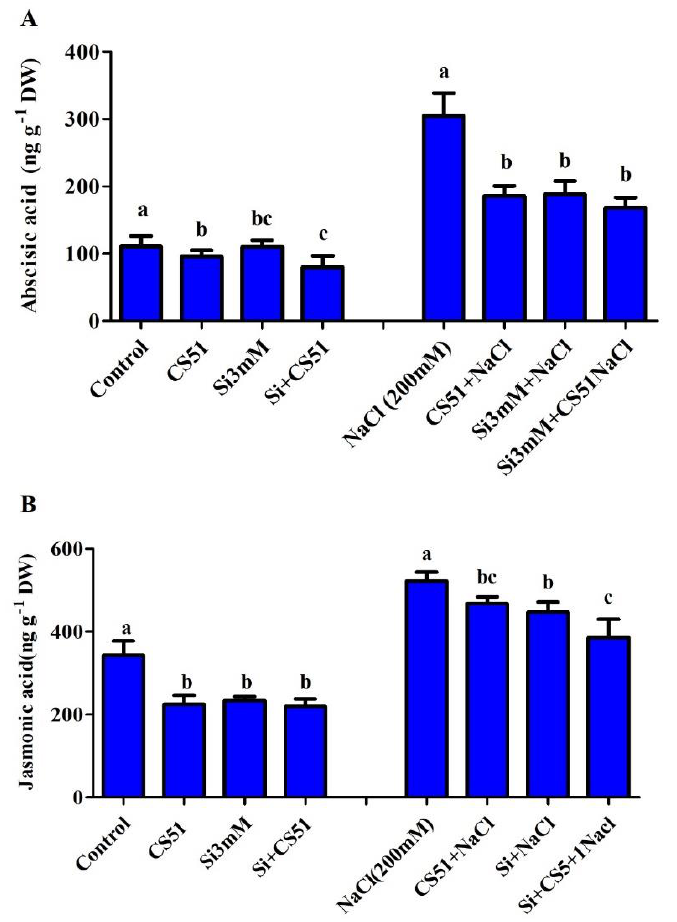
Figure 4. Effect of strain isolate CS51 and Si on ( A ) abscisic acid (ABA) contents and ( B ) jasmonic acid (JA) contents of maize plants grown under elevated NaCl 200 mM. Each value represents the mean ± SD of three replicates. Different letters on columns with error bars (mean ± SD) represent a significant difference among the treatments evaluated by Duncan’s Multiple Range Test (DMRT).